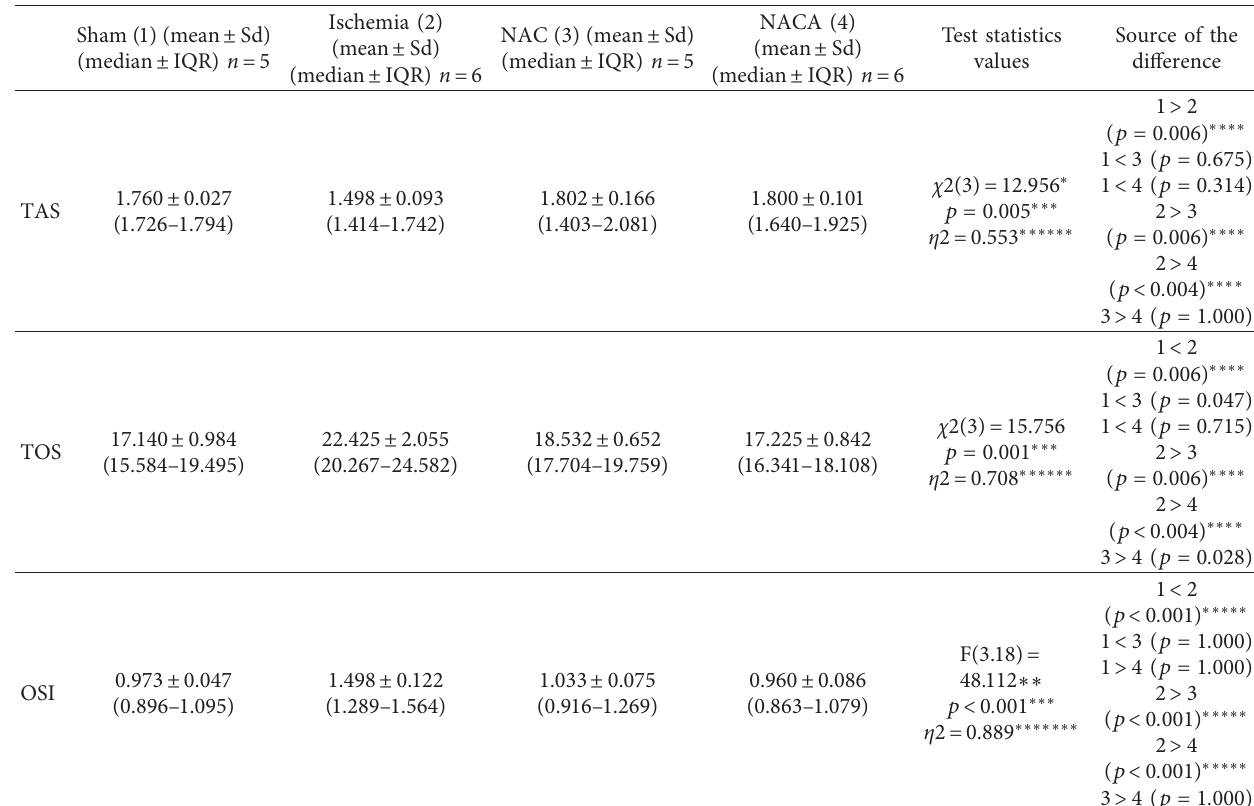
Table 2: Distribution of TAS, TOS, and OSI variables in groups.